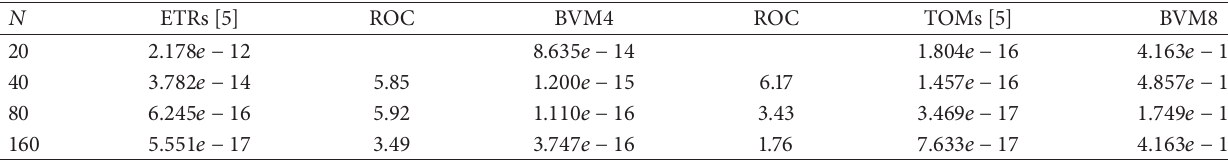
Table 5: Maximum Errors for different stepsizes for Example 4 for 𝜆 = 1 .